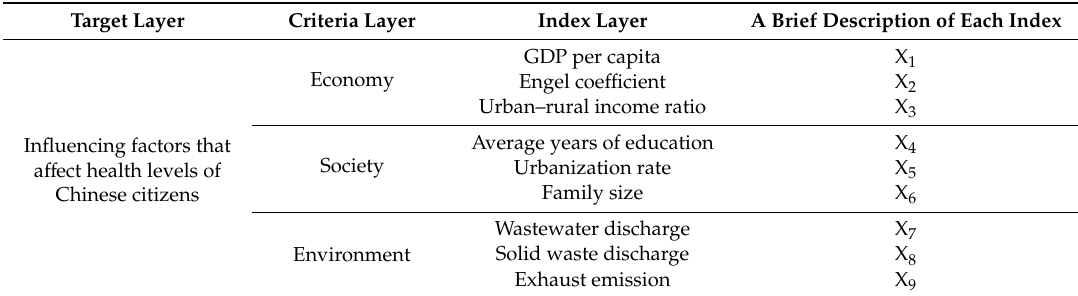
Table 2. The index system used for selecting influencing factors that a ff ect Chinese citizens’ health